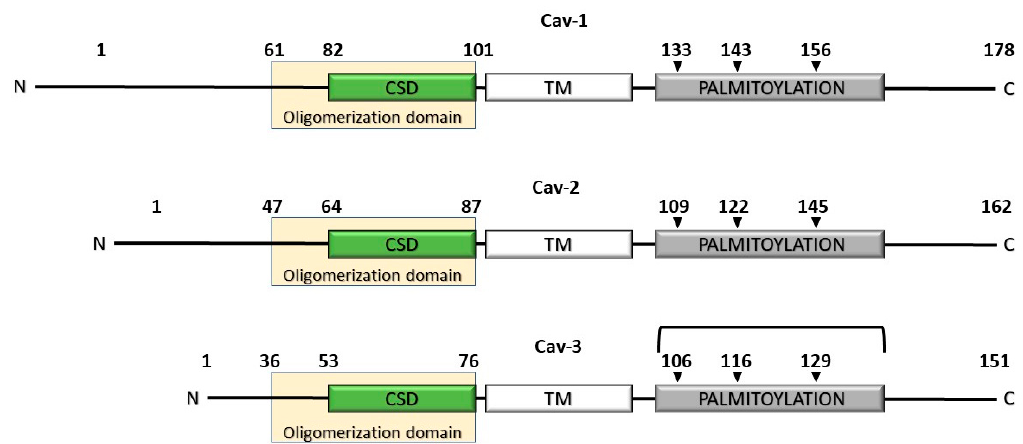
Figure 1. The human caveolin gene family. The indicated palmitoylation sites of cav-3 have been assumed on sequence alignment with cav-1, but they have not been experimentally determined yet.